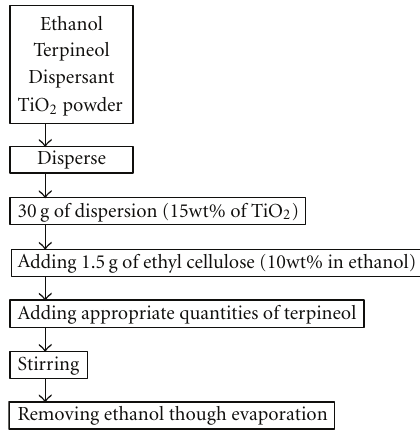
Figure 2: Method for the preparation of TiO 2 paste.